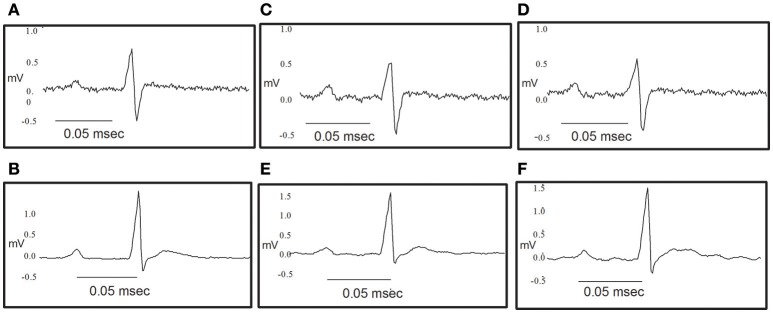
Original traces showing the effect of NS309 and NS4591 on the electrocardiography of the rat heart. (A,B) Representative ECG obtained as a control value for NS309 and NS4591. (C) Representative ECG obtained during NS309 administration. (D) Representative ECG obtained after NS309 administration. (E) Representative ECG obtained during NS4591 administration. (F) Representative ECG obtained after NS4591 administration.